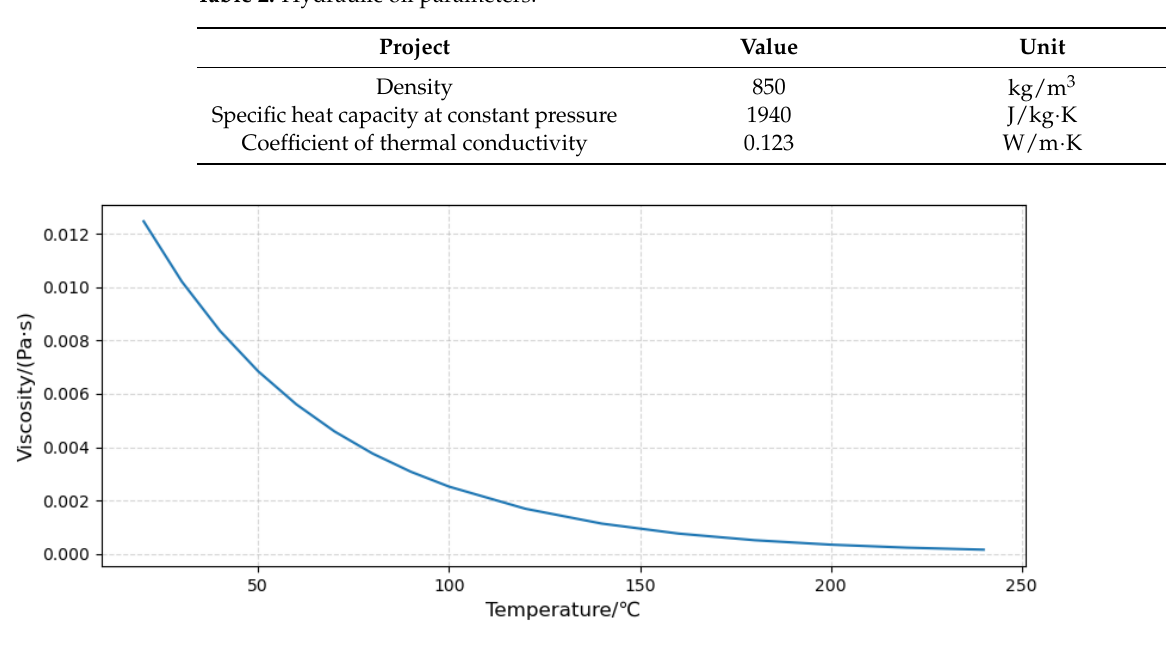
Figure 8. Viscosity curve with temperature.